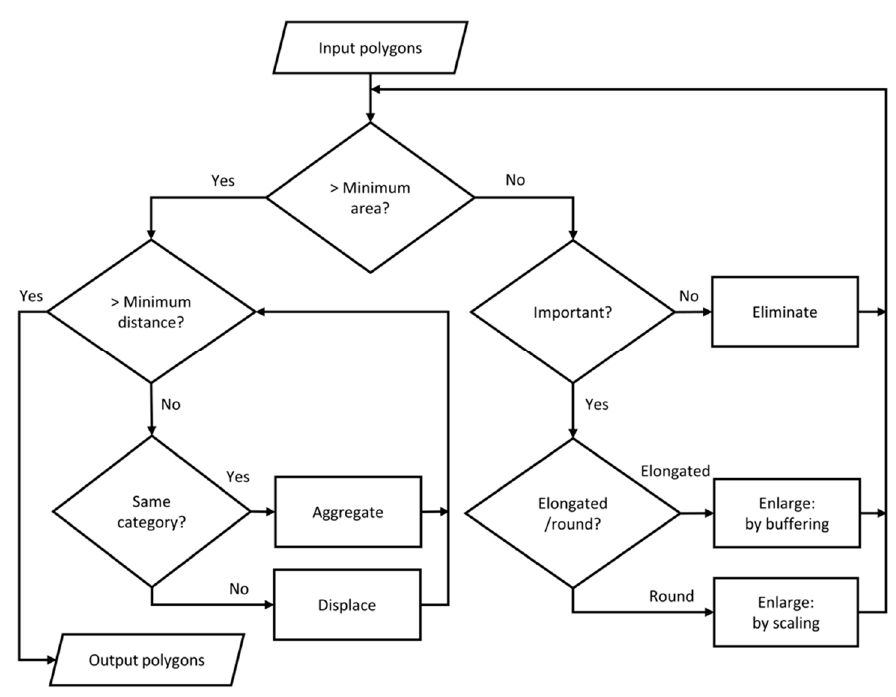
Figure 4. The workflow of the polygon generalization stage, governed by size constraints.